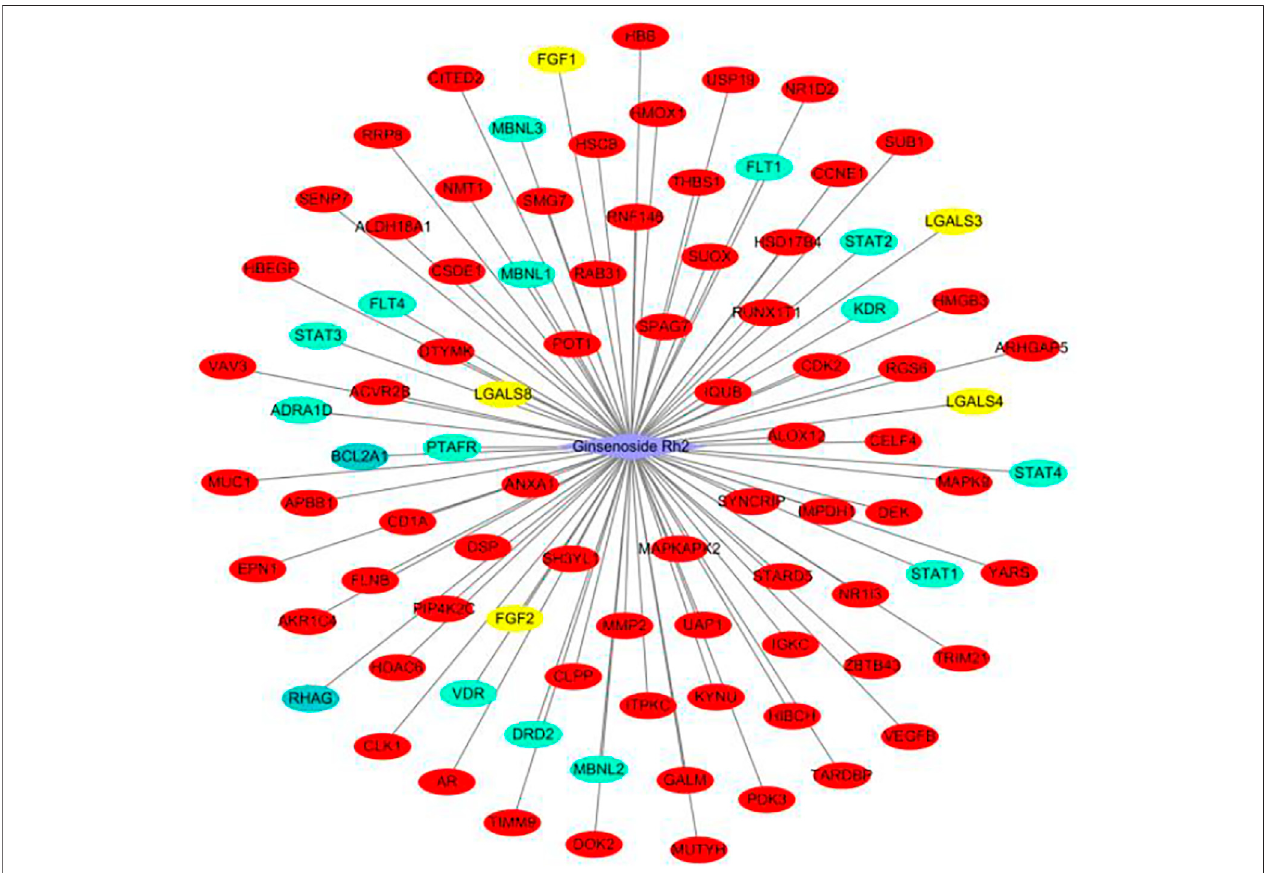
FIGURE 2 | Target network of G-Rh2. Red, yellow, green, and blue ovals, are targets obtained from PharmMapper Server, Similarity ensemble approach, SwissTargetPrediction, and the STITCH database.